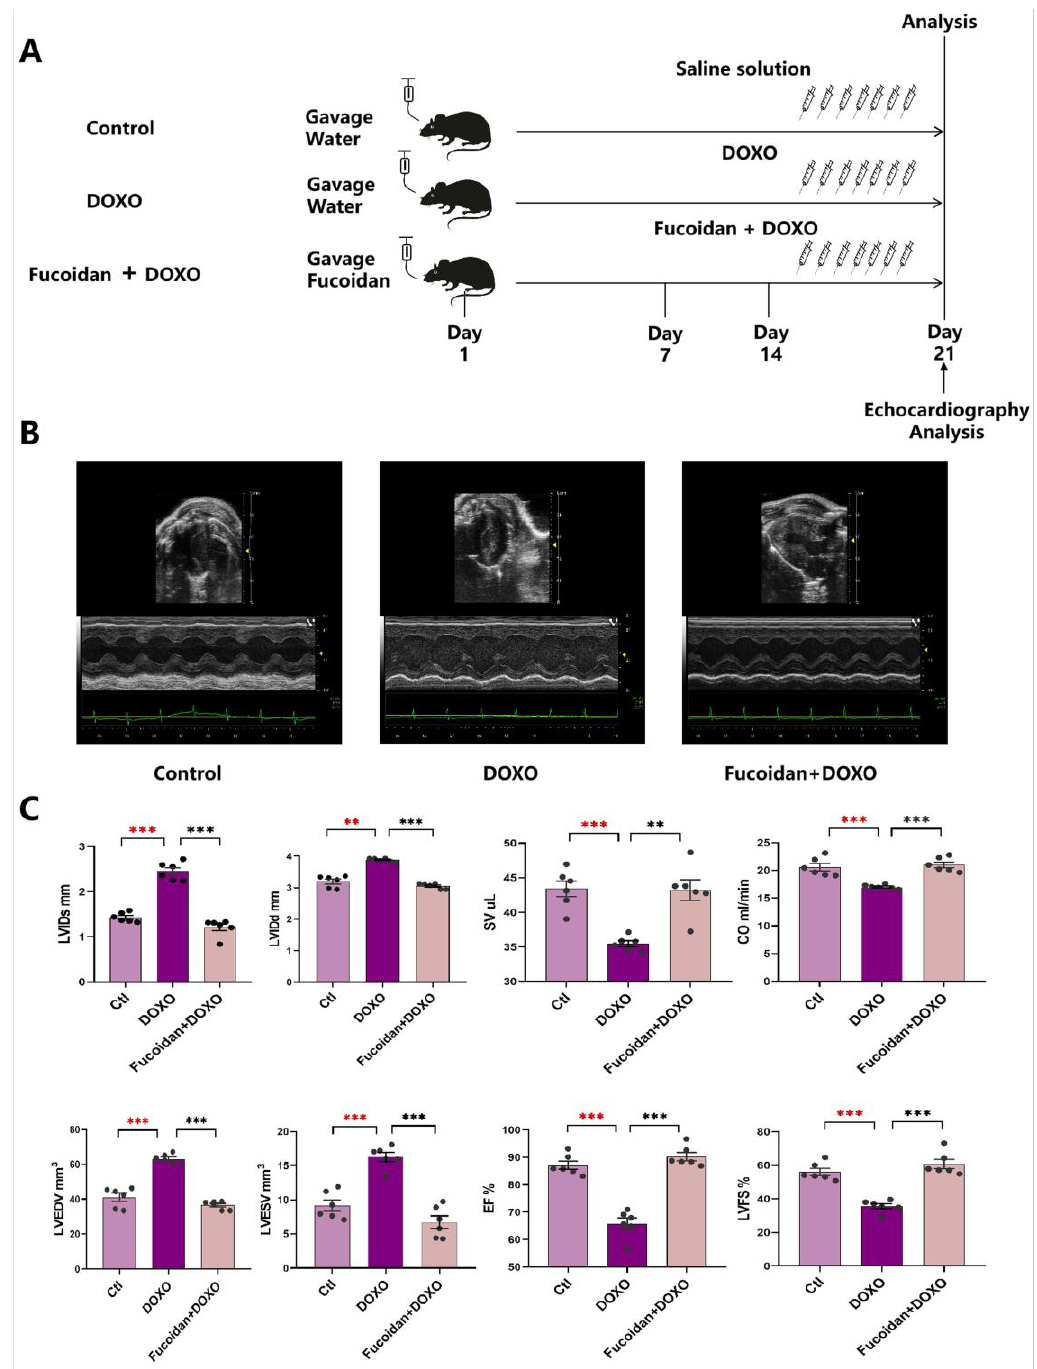
Figure 1. Fucoidan protects against DOXO-induced cardiotoxicity. ( A ) Schematic protocol of treat- ment and echocardiography in mice. C57/BL6J mice were divided into three groups randomly ( n = 6 mice in each group). On day 0, mice in the pre-treated fucoidan + DOXO group were fed orally with fucoidan every day for 21 days, while the mice of the ctl and DOXO groups were given water gavage. On day 15, after daily pre-treatment with water or fucoidan, mice in the DOXO group and the pre-treated fucoidan + DOXO group were intraperitoneally injected with DOXO for the following 7 days, while mice of the ctl group were treated with the saline solution. Cardiac function was monitored by echocardiographic analysis on day 21. Mice were sacrificed after the analysis for subsequent ex vivo assays. ( B ) Fucoidan prevented DOXO-induced left ventricular dilation.